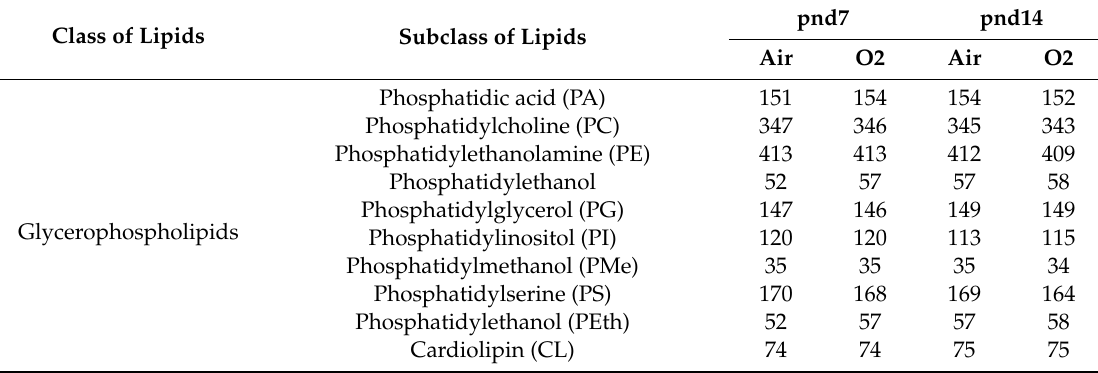
Table 1. Numbers of lipids detected in lung